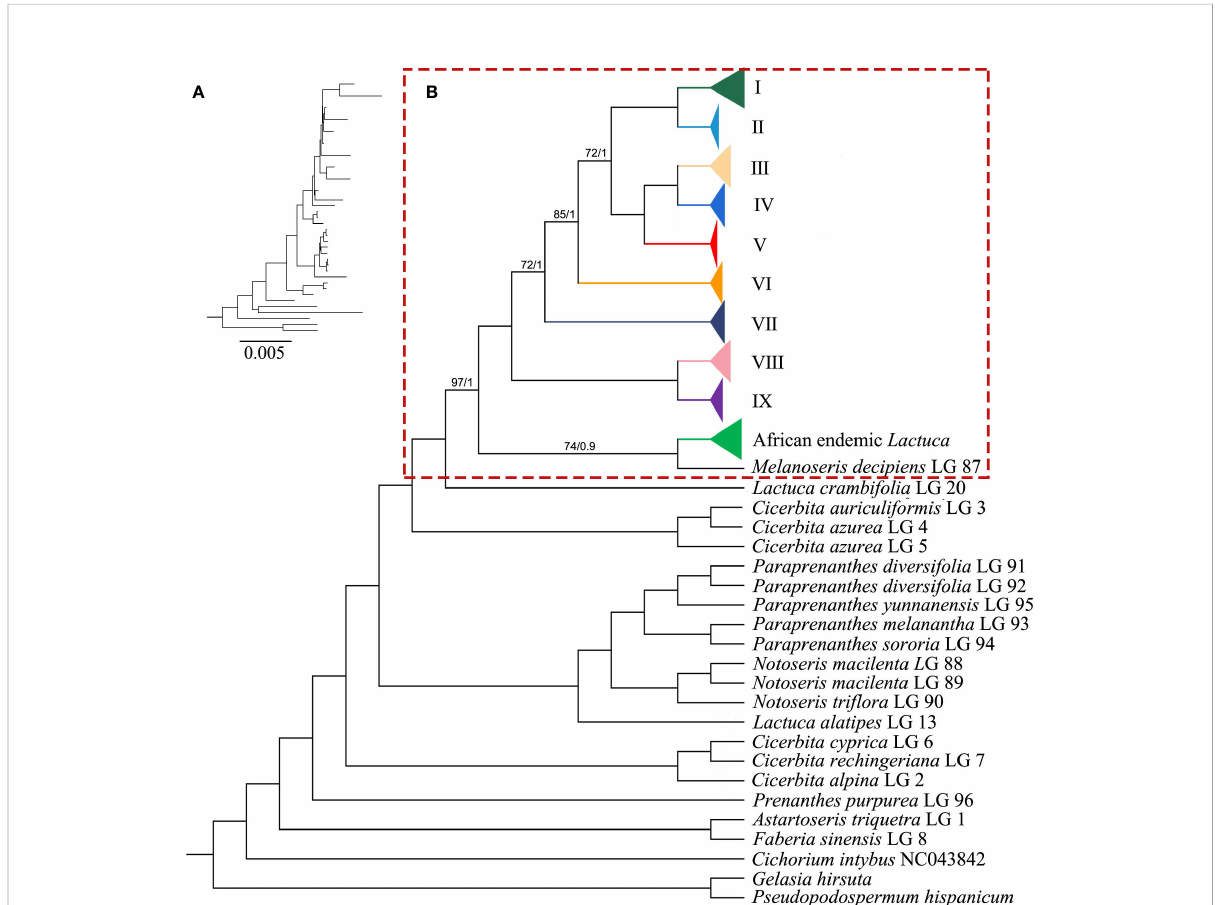
FIGURE 3 Phylogenetic cladogram of Lactuca and related genera based on complete plastomes. (A) Phylogenetic tree with branch length. (B) Phylogenetic cladogram with collapsed clades of Lactuca and AE Lactuca species. The width of the triangle represents the number of species. Support values are maximum likelihood bootstrap (BS) / Bayesian posterior probability (PP). No support values are shown for nodes with full support (BS = 100, PP =